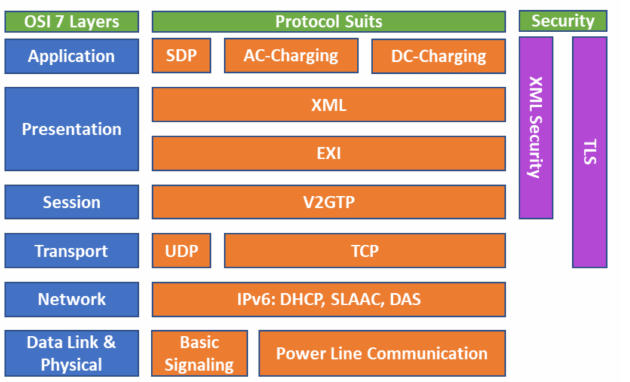
Figure 6. The OSI 7-layer structure of ISO 15118.20